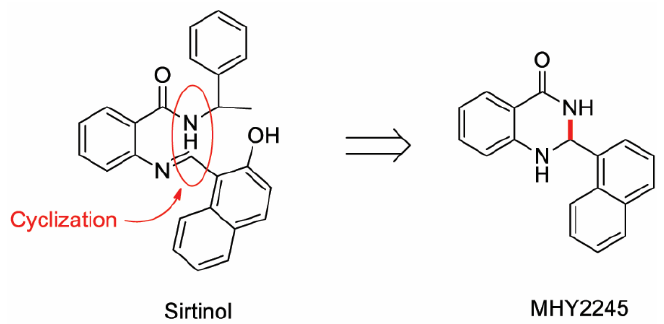
Figure 1. Synthetic scheme for MHY2245. Structures of sirtinol and MHY2245 [2 ‐ (naphthalen ‐ 1 ‐ yl) ‐ 2,3 ‐ dihydroquinazolin ‐ 4(1H) ‐ one].